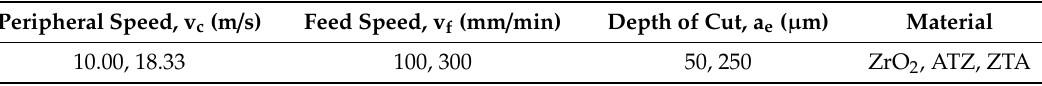
Table 2. Grinding conditions and material selection. Table 3. Design of the process conditions in this